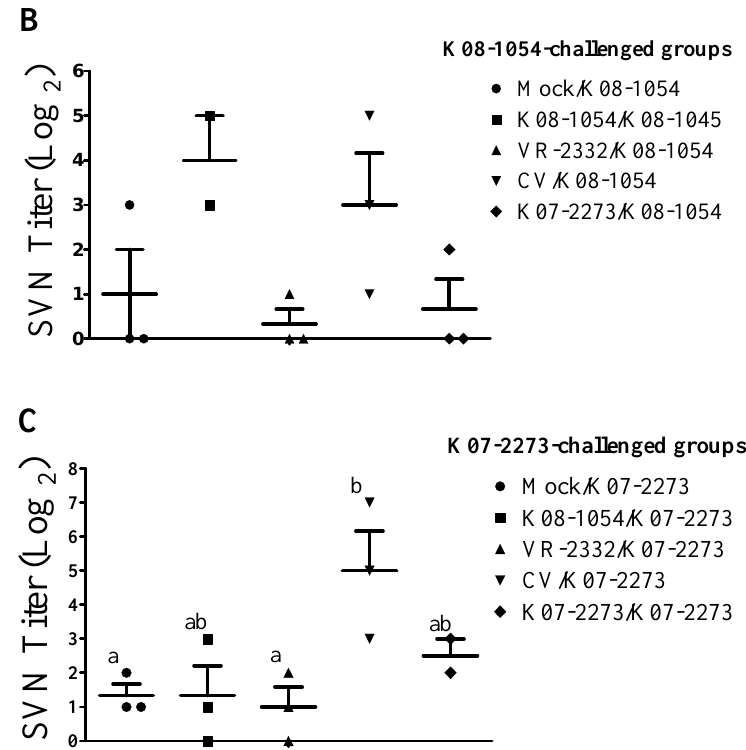
Figure 6. Serum virus neutralization (SVN) antibody titers of vaccinated pigs 21 and 42 dpv. SVN antibody titers of sera collected from pigs vaccinated with K08 ‐ 1054, VR ‐ 2332, CV or K07 ‐ 2273 against each homologous virus at 21 dpv ( A ). Virus ‐ neutralizing antibody titer in sera from K08 ‐ 1054 ‐ challenged groups against K08 ‐ 1054 at 42 dpv ( B ) and virus ‐ neutralizing antibody titer in sera from K07 ‐ 2273 ‐ challenged groups against K07 ‐ 2273 at 42 dpv ( C ). Bars showing different letters represent values significantly different from each other ( p < 0.05).